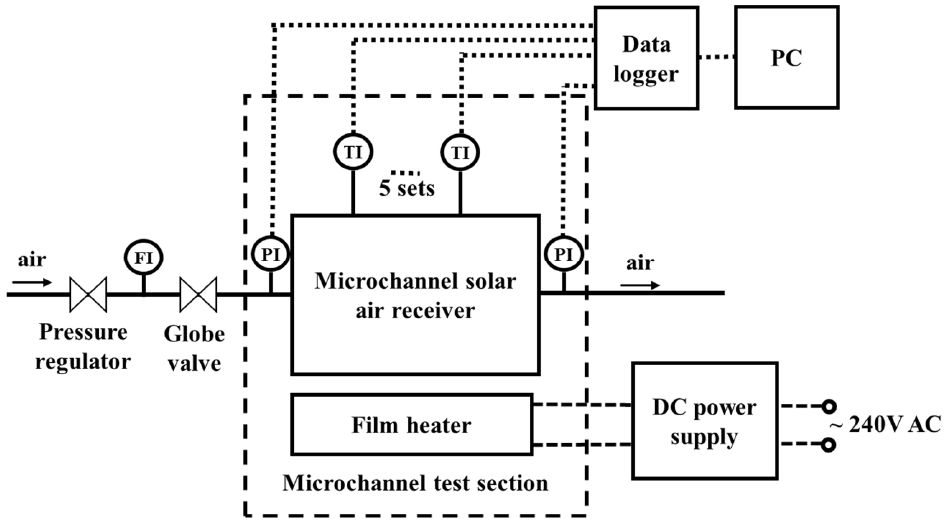
Figure 1. Flow diagram of the MCGS solar air receiver. (TT: Temperature Transmitter; PT: Pressure Transmitter; FI: Flow rate Indicator).